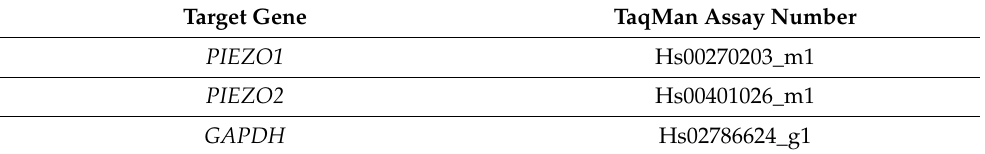
Table 2. TaqMan assays used for qPCR (all from ThermoFisher, Dreieich,